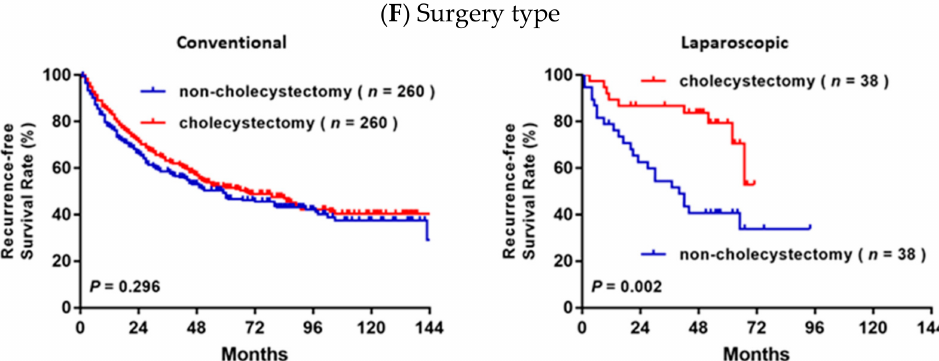
Figure 3. Kaplan-Meier cumulative recurrence-free survival after resection for HCC patients with or without cholecystec- tomy stratified by ( A ) age, ( B ) BCLC stage, ( C ) liver cirrhosis, ( D ) diabetes, ( E ) resection type and ( F ) surgery type.